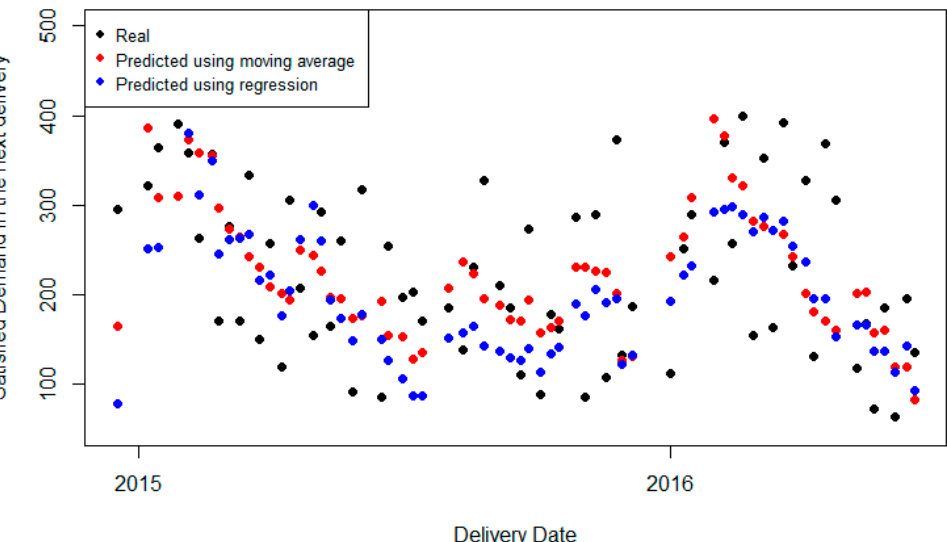
Figure 4. Prediction of satisfied demand in the next delivery (SDNW).